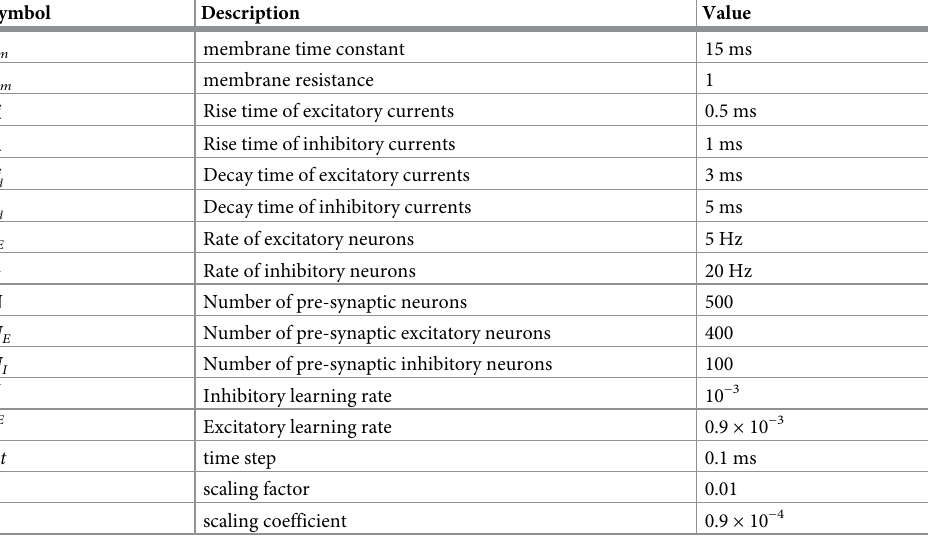
Table 1. List of